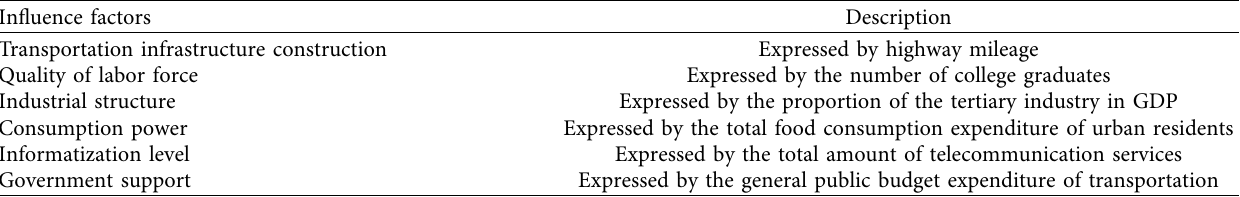
Table 2: Influencing factors of vegetable circulation efficiency in Henan Province.